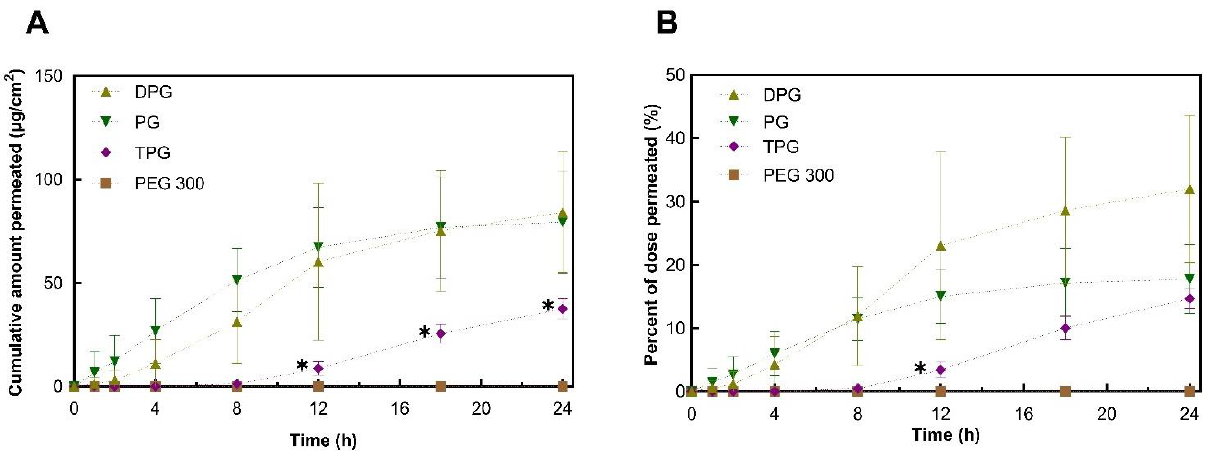
Figure 4. Permeation profiles of vehicles in human epidermis after application of samples expressed as ( A ) cumulative amounts (μg/cm 2 ) and ( B ) percentages (%) of dose applied (mean ± SD, n = 5, * p < 0.05).